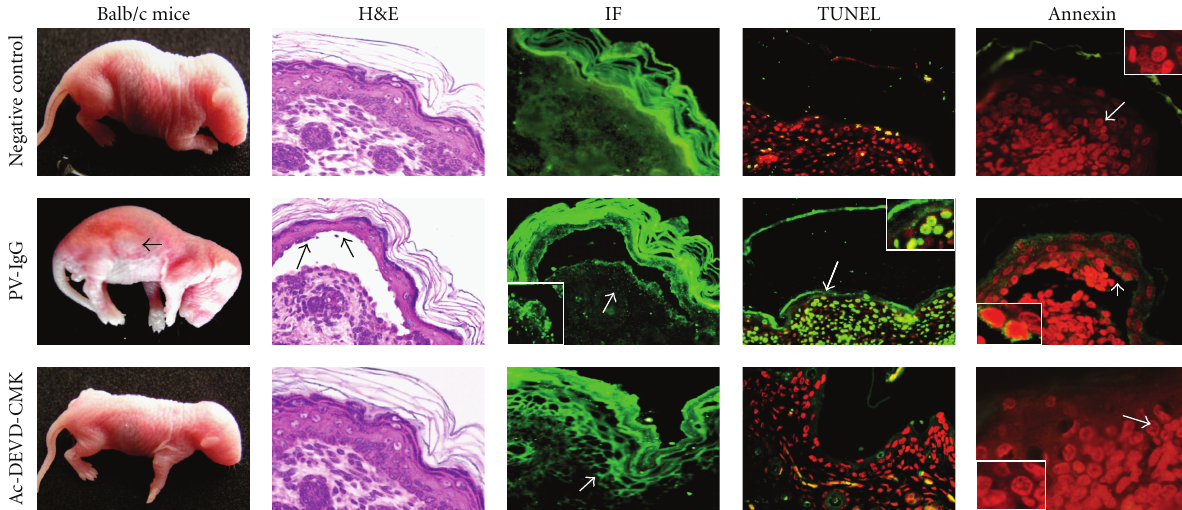
Figure 2: Induction of acantholysis in Balb/c mice and the prevention of blistering by caspase inhibition. The top panel shows representative figures of a negative control Balb/c mouse injected with normal IgG. This mouse did not develop blisters, show IgG deposition along intercellular spaces or initiate apoptosis. The middle panel shows a mouse injected with pemphigus vulgaris IgG that developed macroscopic abdominal and leg blisters. H&E staining shows that blisters were suprabasally located (arrow) with acantholytic cells (arrow), also PV-IgG was deposited in the roof and base (arrow) of the blister, and apoptotic cells are shown in green (arrow) as demonstrated using TUNEL and annexin staining. The bottom panel shows a mouse treated with the Ac-DEVD-CMK peptide prior to pemphigus IgG injection. The skin biopsy was taken 24 h after injection. The animal did not develop blisters despite the PV-IgG deposition along intercellular spaces. The caspase inhibitor blocked apoptosis of keratinocytes (red). PV-IgG: pemphigus vulgaris IgG. H&E: haematoxilin and eosin. IF: